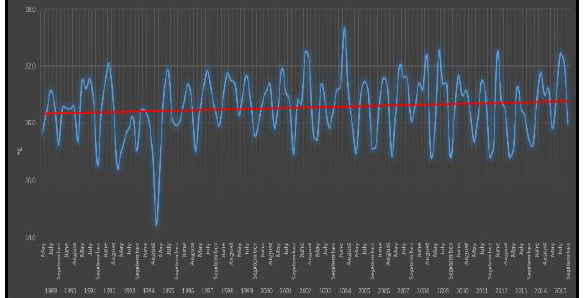
Figure 3. A long term of air temperature in study area from 1989 to 2015 by monthly